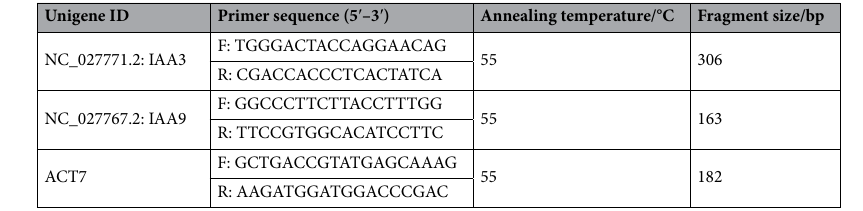
Table 3. List of primers used for the real-time RT-PCR.